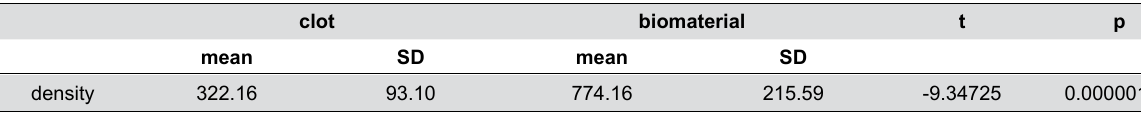
sd= statistically significant difference